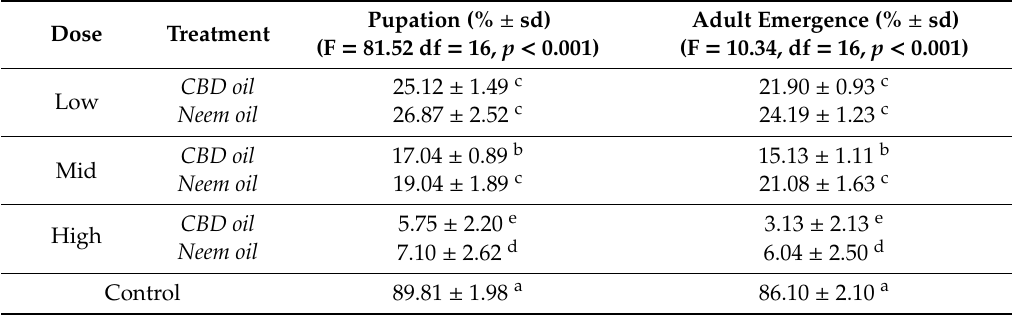
Table 5. Mean e ff ect of CBD oil and neem oil on pupation and adult emergence (% ± sd) of 4th larval instars of T. confusum . Means of the same column followed by the same letter are not significantly di ff erent (Long Rank test, p = 0.05).